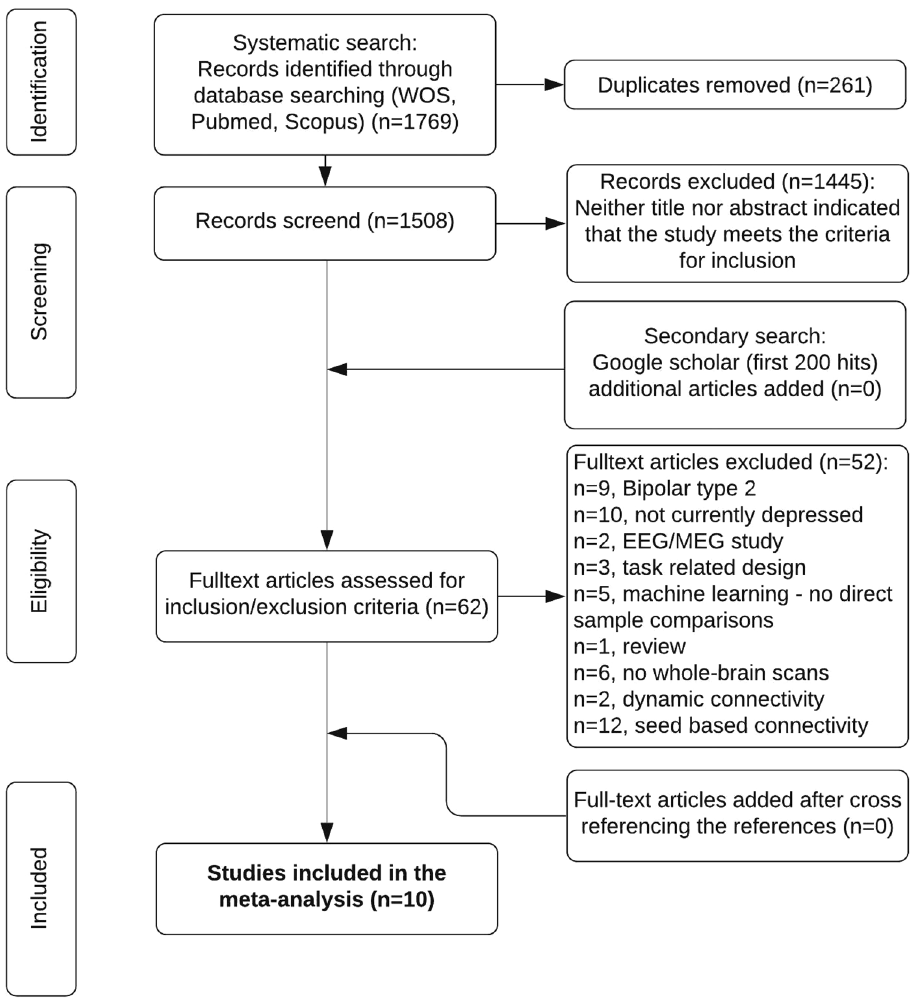
Figure 2. PRISMA flowchart showing the process of identifying the articles included in the meta-analyses.